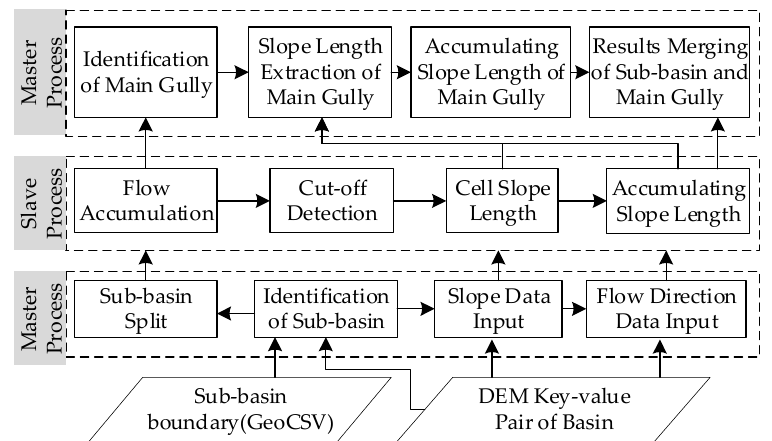
ISPRS Int. J. Geo-Inf. 2019 , 8 , x FOR PEER REVIEW Figure 7. Diagram of parallel algorithm for slope length. Figure 7. Diagram of parallel algorithm for slope length.